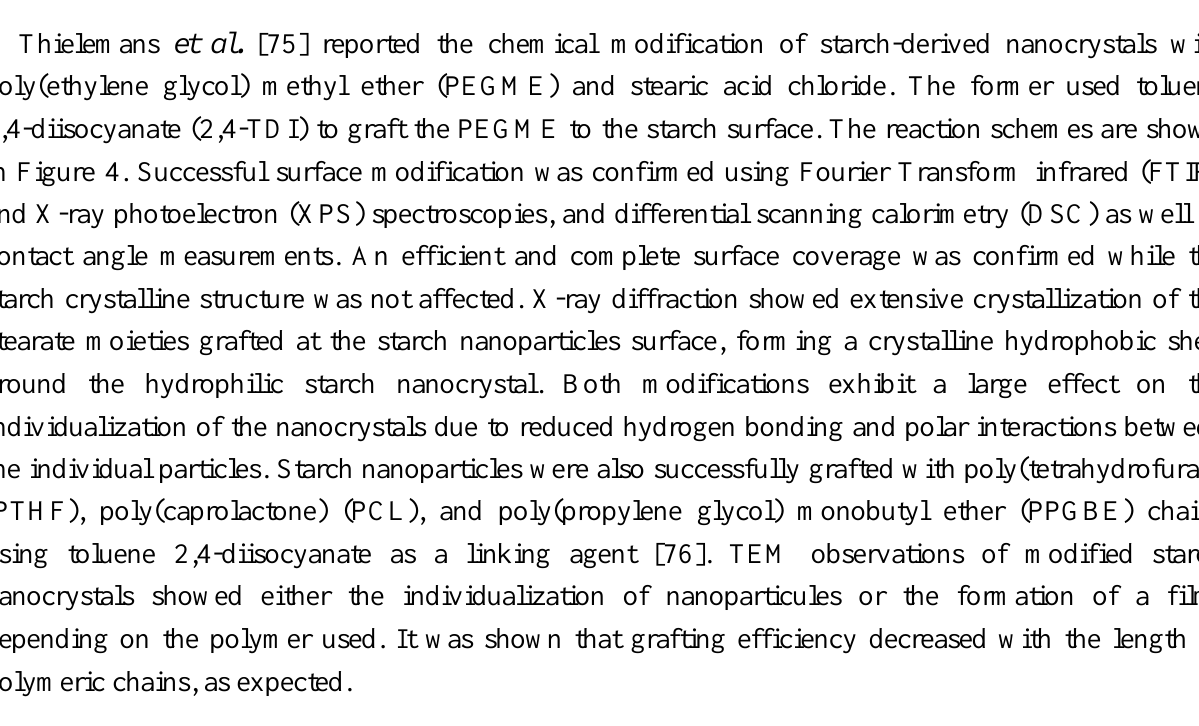
Figure 4. Reaction schemes for the grafting of (a) stearates and (b) PEGME to the starch nanocrystal surface